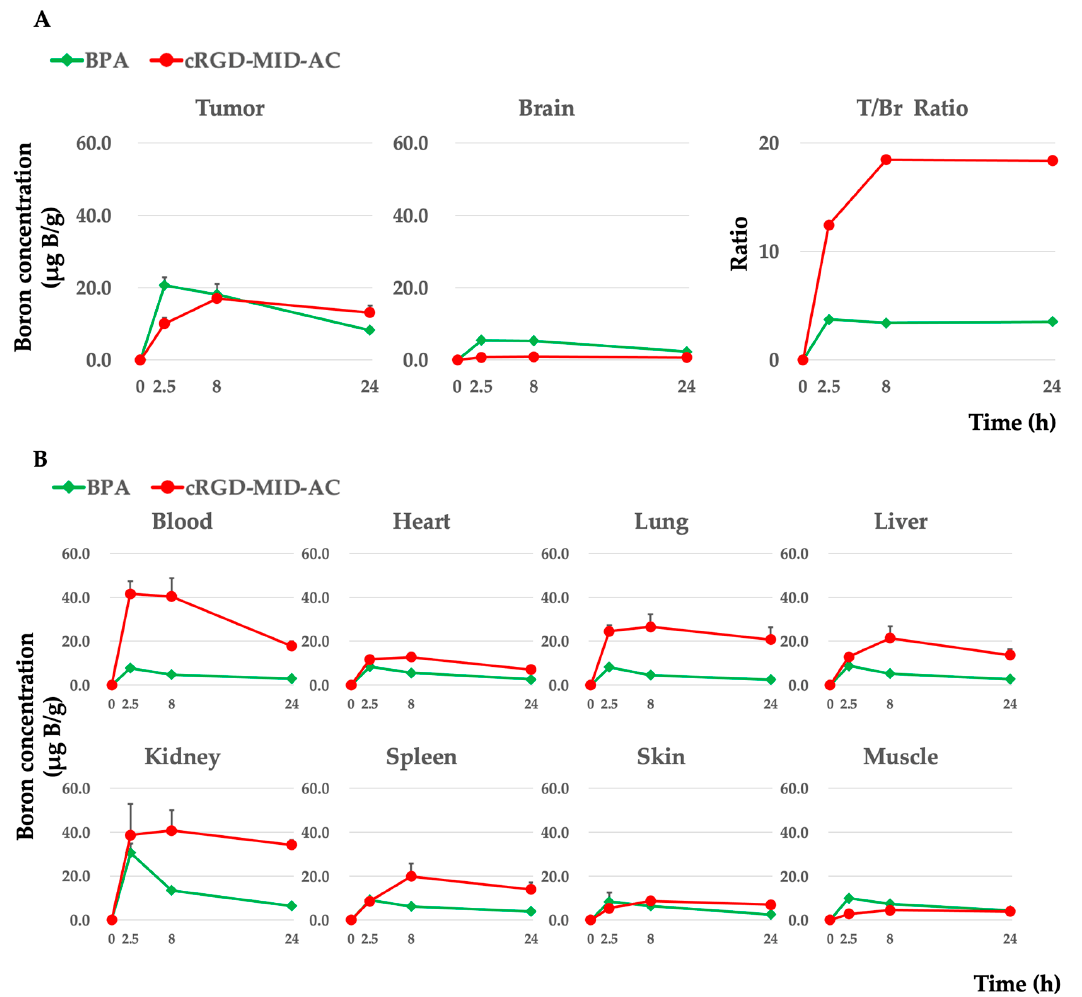
Figure 3. ( A ) Boron concentrations in the tumor and brain (normal brain) in the F98 glioma-bearing rat brain tumor model after the implantation of 10 5 F98 glioma cells. Each boron carrier was administered with 12 mg boron (B)/kg body weight (b.w.) doses. At 2.5, 8, and 24 h after intravenous administration, each rat was euthanized, and each tissue was removed. The boron concentration in each tissue was measured by ICP-AES. The mean boron concentration of each tissue was defined as µg B/gram ± standard deviation (SD). In addition, the tumor/brain boron concentration ratio (T/Br ratio) is shown. ( B ) Boron concentrations in each tissue except the tumor and the brain are shown. Table 1. Boron concentrations in the tumor, brain (normal brain), and blood after intravenous ad- ministration of each boron carrier in F98 glioma-bearing rats.